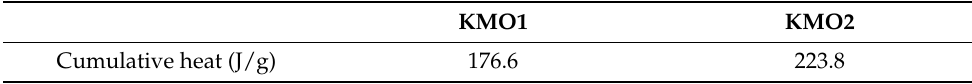
Table 7. Compressive strength of the KMO